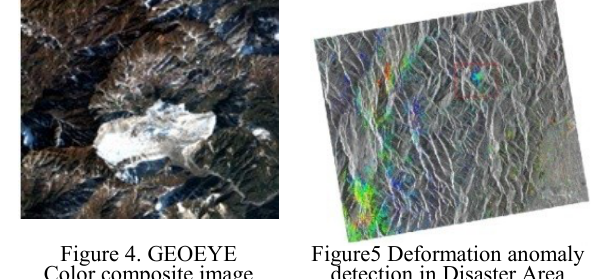
Figure 4. GEOEYE Color composite image